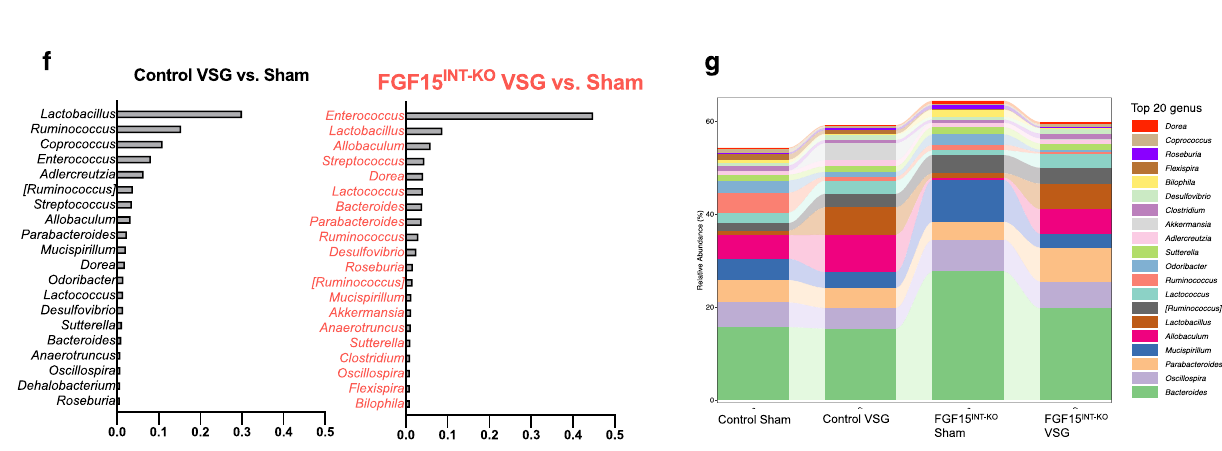
Fig. 7 Intestinal FGF15 modulates microbiota in cecal content. a Chao1 abundance and b Shannon index diversity of the gut microbiota in the cecal contents. LEfSex analysis depicting nodes within the bacterial taxonomic hierarchy that are enriched in cecal microbiota from c Control Sham versus FGF15 INT-KO Sham and d Control Sham versus VSG and e FGF15 INT-KO Sham versus VSG. Diagrams generated by LEfSe indicating differences at phylum , order , class , family , and genus levels between the two groups. f Top-ranked taxa at genus level identi fi ed by random forest analysis according to their ability to discriminate the microbiota of Sham and VSG mice per genotype in decreasing order of discriminatory importance. A comparison of the abundance of markers in VSG relative to Sham counterparts in each genotype. g . Differences in relative abundance of taxa at genus level. Animal number Control Sham ( n = 6), Control VSG ( n = 7), FGF15 INT-KO Sham ( n = 7), FGF15 INT-KO VSG ( n = 5). Data in ( a , b ) are shown as means±SEM. * p <0.05 (two-way ANOVA with Tukey ’ s post hoc signaling through FXR as a molecular link mediating the bene- fi cial metabolic effects of elevated bile acids following VSG 12,13 . Secretion of FGF15/19 is a key response to FXR activation.